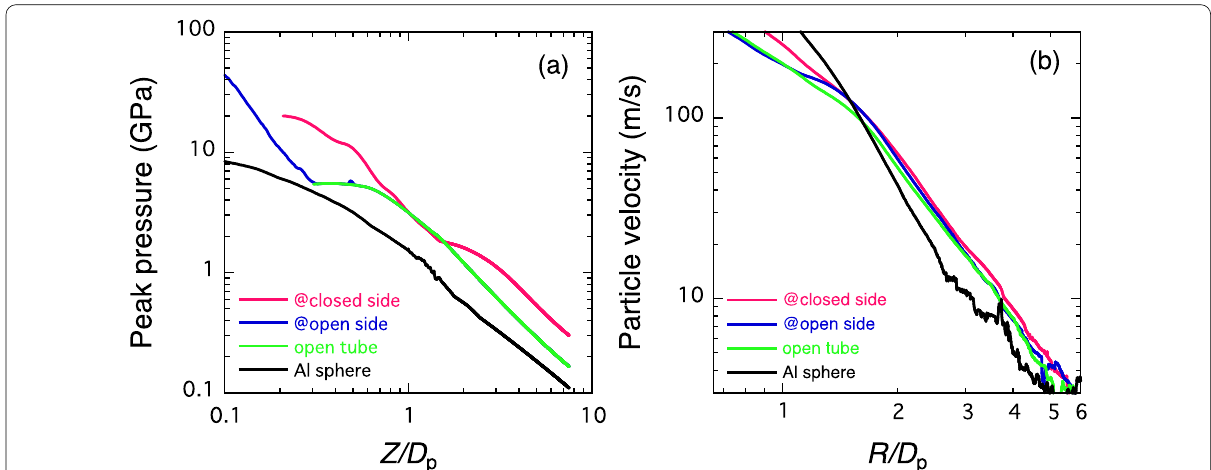
Fig. 6 Profiles of a peak pressure and b particle velocity along the central axis and the target surface, respectively, for the numerical results shown in Fig. 5. The profiles for the copper closed-tube projectile impacting at the open side and the open tube projectile are very similar and hence, the lines are almost